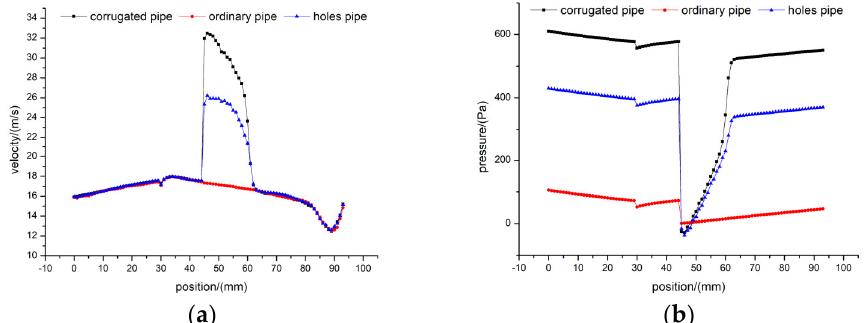
Figure 7. Effect of pressurization type on airflow velocity and pressure in seed tube. ( a ) Variation curves of airflow velocity in different seed tube; ( b ) Variation curves of pressure in different seed tube.3.3. Effect of Seed Tube Structure on Seed Distribution.